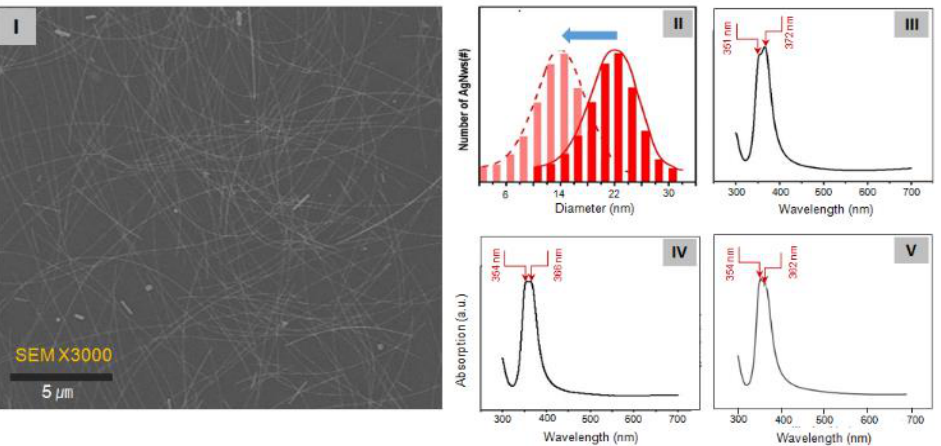
Figure 3. [ I ] SEM images of Ag NWs at low magnification (3000×). The average diameter of the NWs is